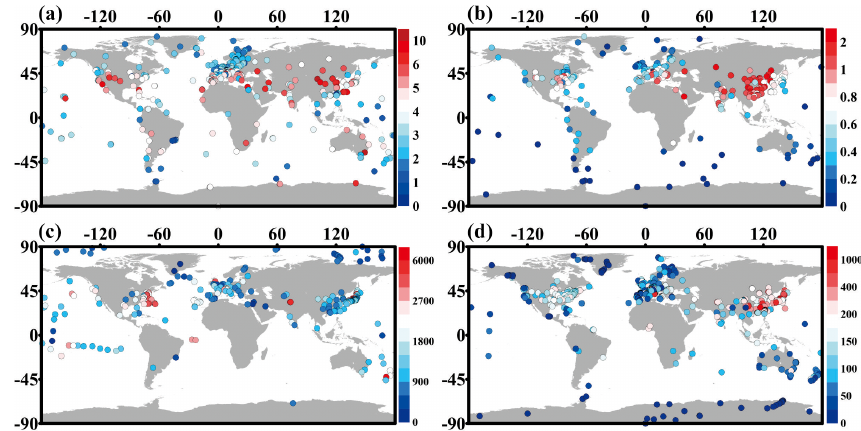
Figure 4. Global distribution of (a) 7 Be annual air concentration (mBqm − 3 ), (b) 210 Pb annual air concentration (mBqm − 3 ), (c) 7 Be annual depositional flux (Bqm − 2 yr − 1 ), and (d) 210 Pb annual depositional flux (Bqm − 2 yr − 1 ). For those sites with multiple datasets, a weighted average was calculated based on sampling durations.